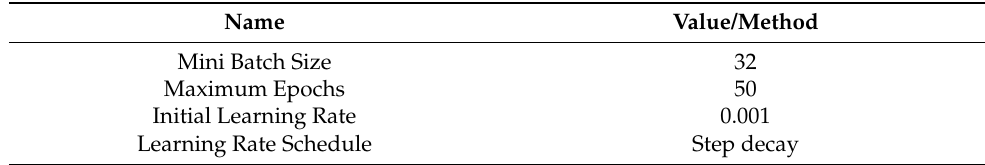
Table 2. List of major hyperparameters and their value.